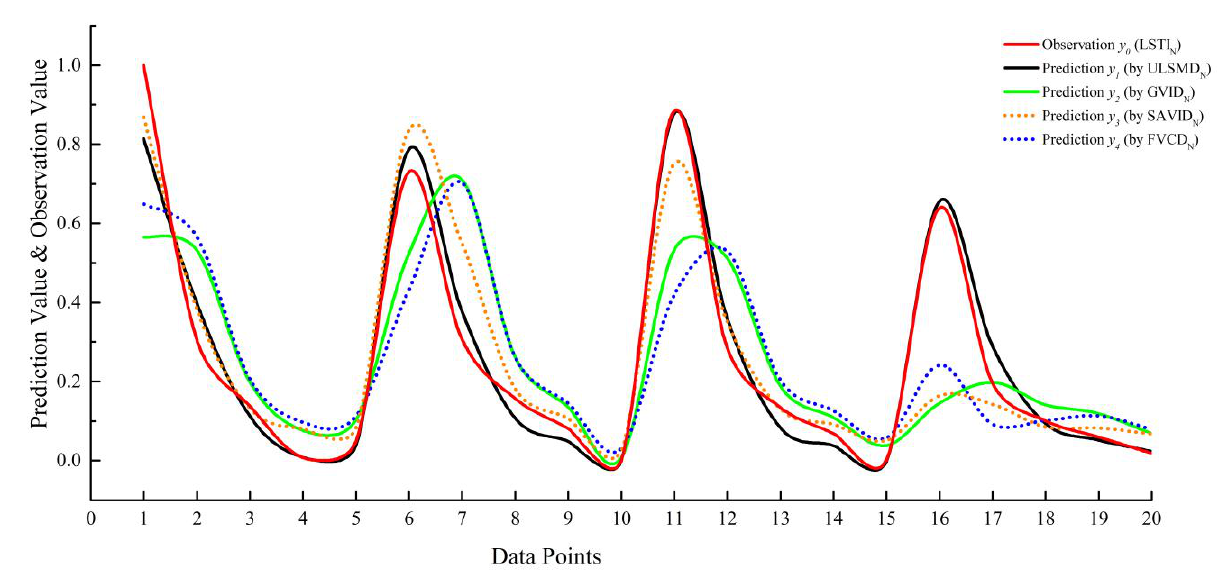
Figure 11. Change trends of the LSTI N predicted value and the LSTI N observation value.